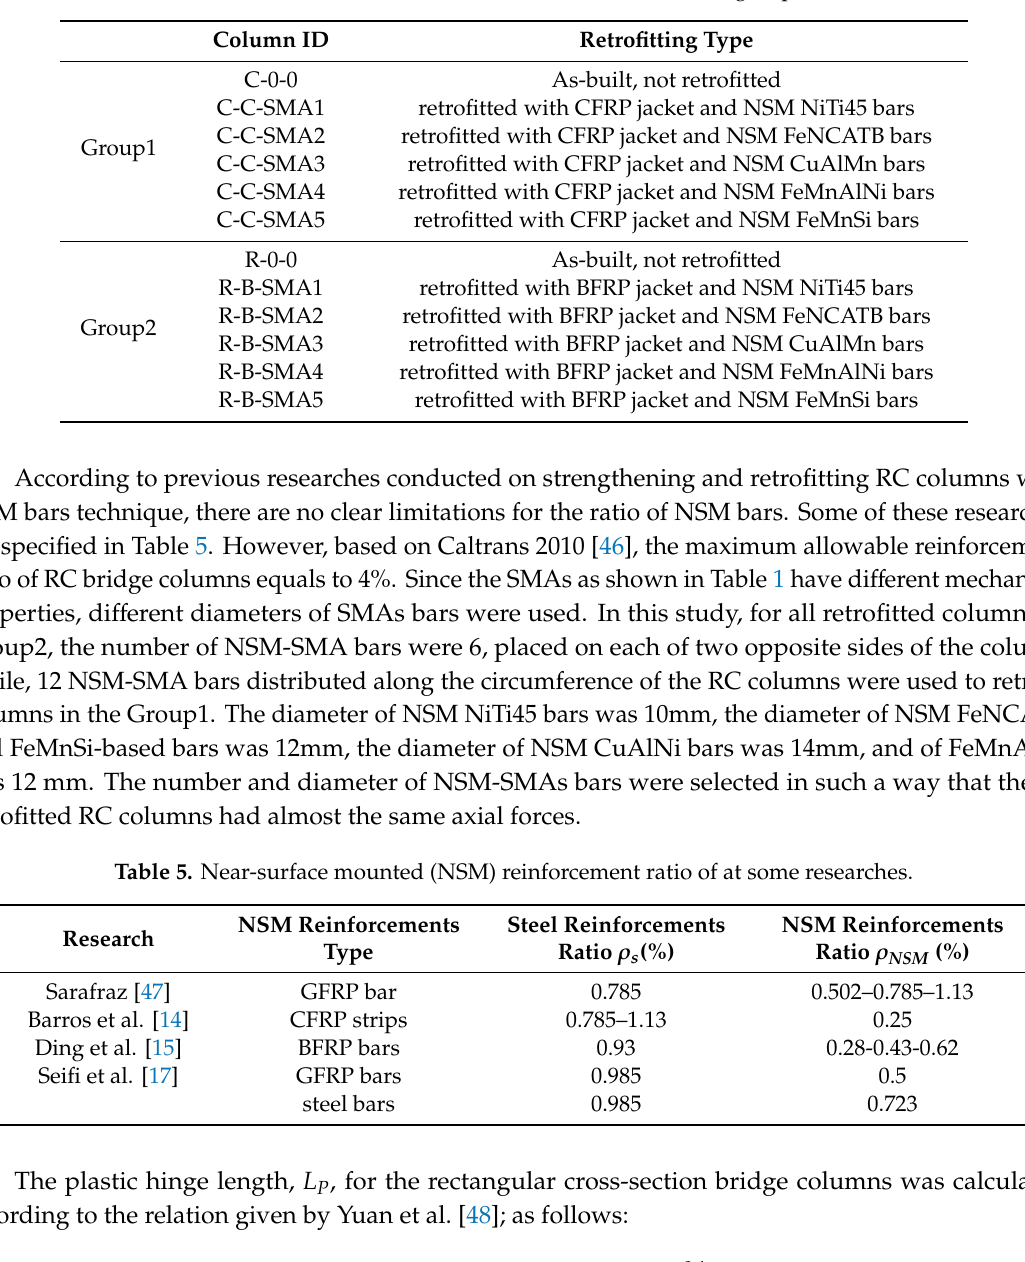
Table 4. As-built and retrofitted columns of the two groups.